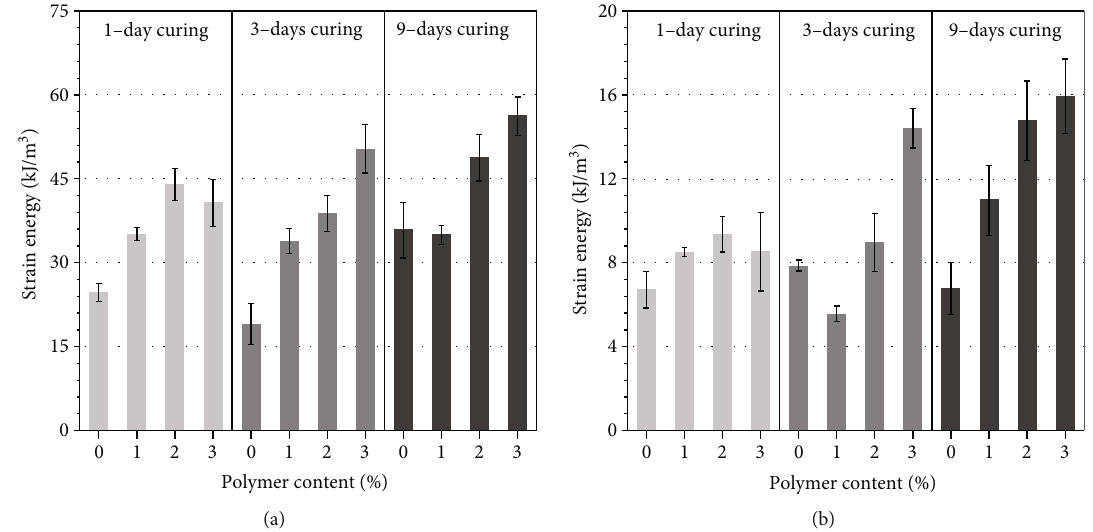
Figure 7: Variation of energy absorption with polymer content and curing time. (a) Specimens cured in room condition and (b) specimens cured in optimum water content